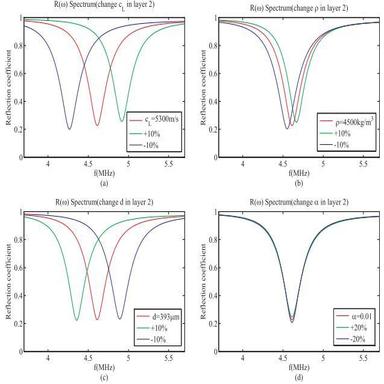
The theoretical reflection spectrum of the aluminum-TC4 bi-layered structure with the changeable properties in layer 2 including the (a) longitudinal wave velocity (b) density (c) thickness and (d) attenuation.